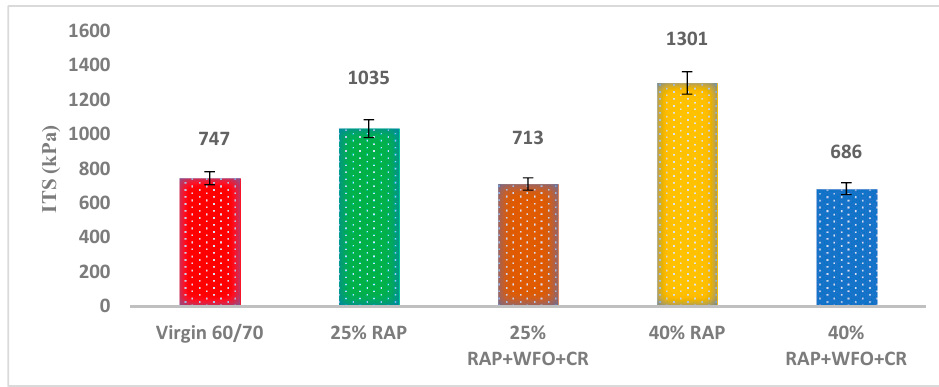
Figure 2. ITS for the virgin, RAP and recycled asphalt mixture at 25 °C. The ITS results were analysed using paired sample t -test to compare the significance of the group means of the virgin asphalt containing RAP and the recycled asphalt mix- tures. Table 14 shows a significant difference in the ITS results. There was a statistically significant difference between the virgin asphalt and asphalt mixtures with 25% and 40% RAP contents ( p < 0.05), which indicates the effect of adding RAP on the strength of the asphalt mixture. However, there was no statistically significant difference between the virgin asphalt and asphalt mixtures containing WFO, CR and 25% RAP and 40% RAP ( p > 0.05), which indicates that WFO and CR reduced the hardness of the RAP asphalt mix- ture. In summary, the ITS for the asphalt mixtures containing WFO, CR and 25% RAP and 40% RAP was comparable to the ITS of the virgin asphalt. Table 14. The significant difference in the group means for the ITS for the virgin asphalt with RAP and the recycled asphalt mixture.